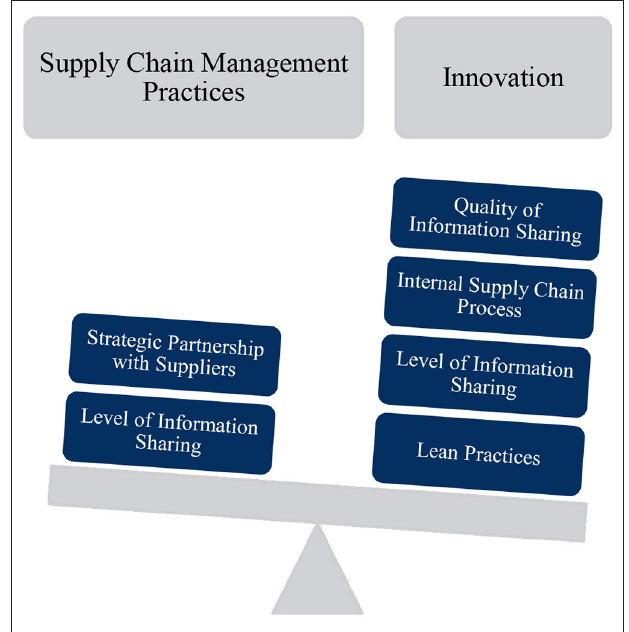
FIGURE 2 | The theoretical framework of supply chain management